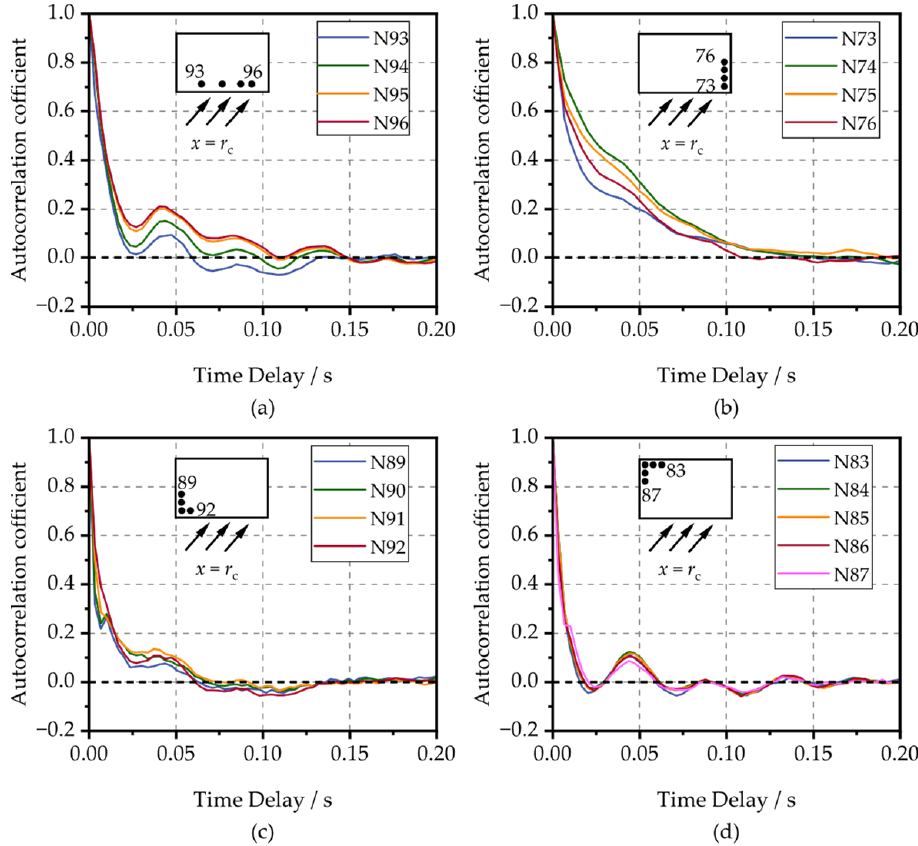
Figure 10. Autocorrelation coefficient functions of pressure time series on roof taps. ( a ) N93-N96; ( b ) N73-N76; ( c ) N89-N92; and ( d ) N83-N87.